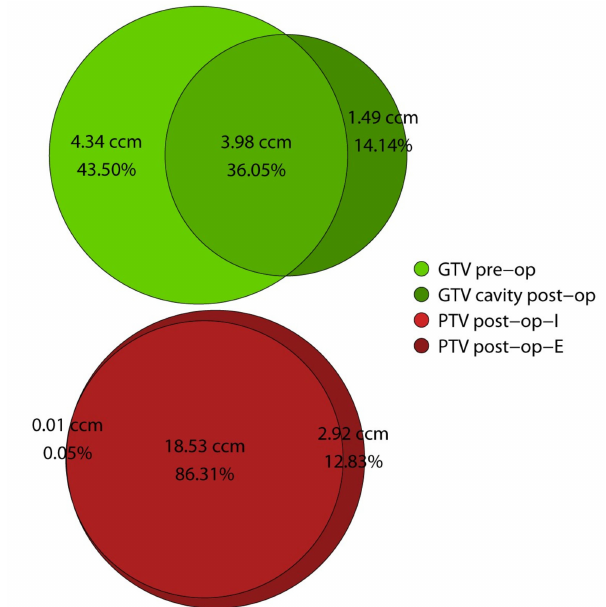
Figure 3. Venn diagram illustrating similarity, areas of overlap and difference between target volumes. Median absolute volumes (ccm) are indicated above; below are listed volumes relative to the combined sum of the two respective targets (%). Further details available in Table 3. Abbreviations: GTV: gross target volume; PTV: planning target volume; pre-op: pre-operative setting; post-op-I: post-operative involved field (cavity + 3 mm); and post-op-E: post-operative extended field (including surgical